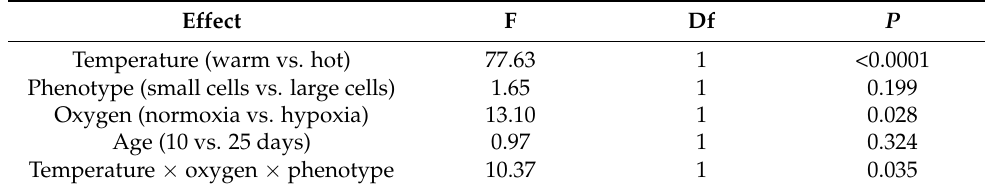
Figure 3. The effects of temperature and oxygen conditions on flight performance differed between adult males of D. melanogaster originating from two different developmental conditions (standard food (control flies) vs. standard food supplemented with rapamycin (rapamycin flies)). All tested flies underwent development at 20.5 ◦ C. When the flies were exposed to more metabolically demanding thermal conditions (hot, 29 ◦ C) and their wing-beat frequency increased, hypoxia slowed flight performance equally in the control (large cells) and rapamycin (small cells) flies. However, when flies were exposed to less demanding thermal conditions (warm, 24 ◦ C) and their wing-beat frequency was lower, oxygen retardation was only observed in the control flies, whereas the rapamycin flies did not respond to the oxygen level. The graph shows the 3-way interaction with means and 95% confidence intervals estimated from a statistical model (see Table 1 for model details). Data on wing-beat frequency were back transformed for the purpose of generating this graph to make it easier to read the actual values. Table 1. Results of a general linear mixed model of wing-beat frequency in two cell-size phenotypes of Drosophila melanogaster males (developed at a common temperature (20.5 ◦ C) on either food sup- plemented with rapamycin (small cells) or food without rapamycin (large cells)). Flight performance was measured in two age classes (males aged 10 and 25 days) in four types of conditions: two elevated temperatures (warm, 24 ◦ C and hot, 29 ◦ C) combined with two oxygen levels (normoxia and